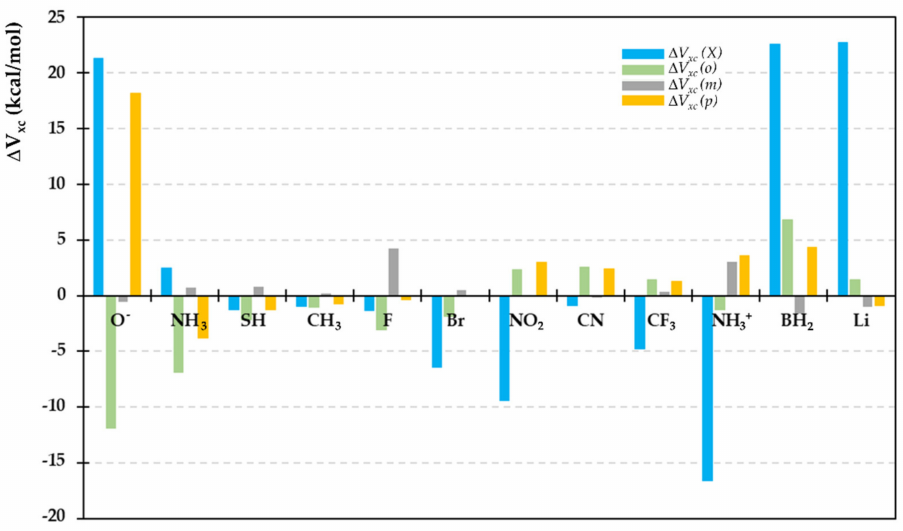
Figure 6. Vicinal exchange-correlation energies relative to benzene ( ∆ V xc ) in the set of selected systems. See the text for a description. All data in kcal/mol, referred to the vicinal V xc value in benzene, equal to − 100.4